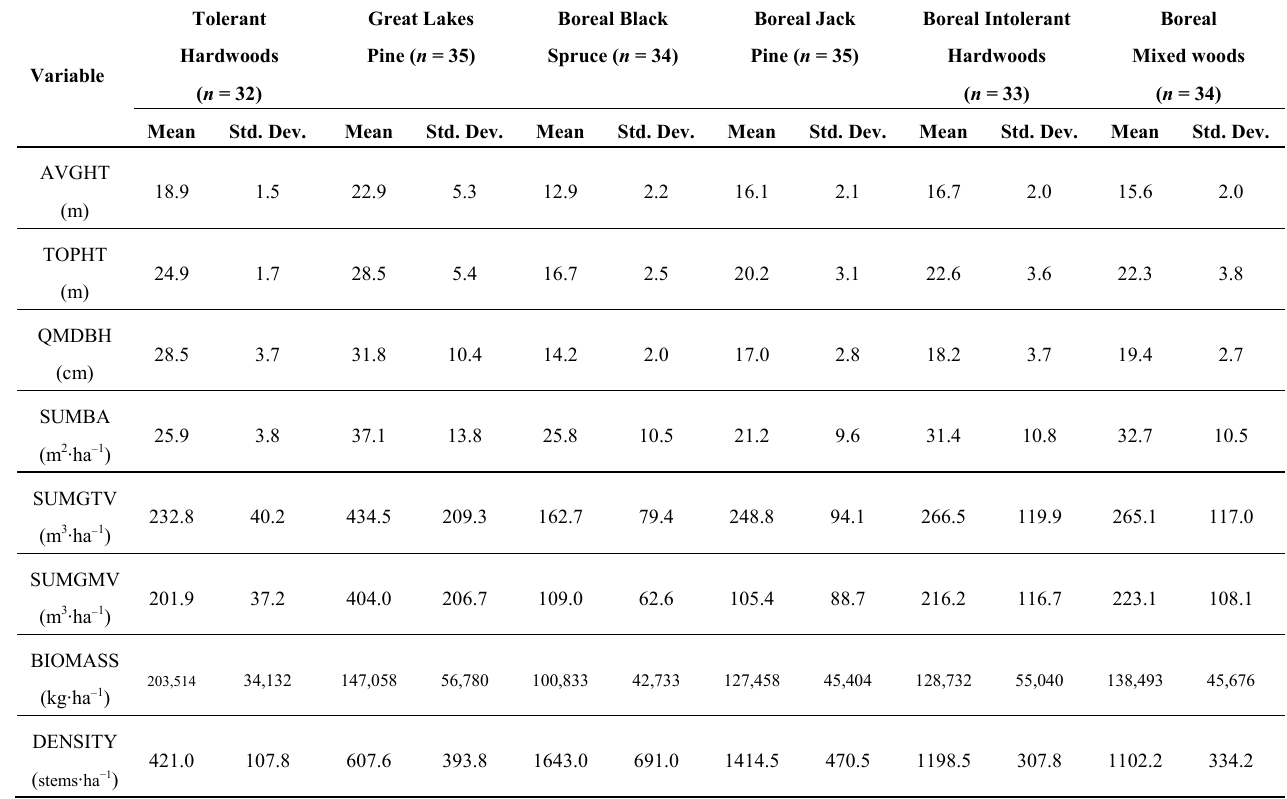
Table 2. Field data statistics for each study site and forest